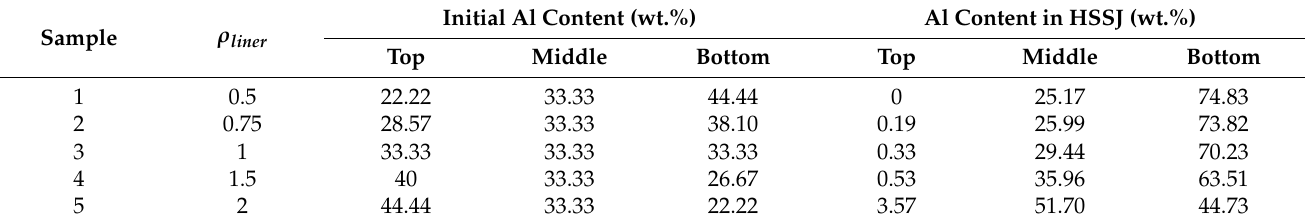
Figure 17. Liner models of different particle distributions: ( a ) 𝜌 (cid:3039)(cid:3036)(cid:3041)(cid:3032)(cid:3045) = 0.5 , ( b ) 𝜌 (cid:3039)(cid:3036)(cid:3041)(cid:3032)(cid:3045) = 0.75 , ( c ) 𝜌 (cid:3039)(cid:3036)(cid:3041)(cid:3032)(cid:3045) = 1 , ( d ) 𝜌 (cid:3039)(cid:3036)(cid:3041)(cid:3032)(cid:3045) = 1.5 and ( e ) 𝜌 (cid:3039)(cid:3036)(cid:3041)(cid:3032)(cid:3045) = 2 . Note: The material colors are the same as in Figure 15.